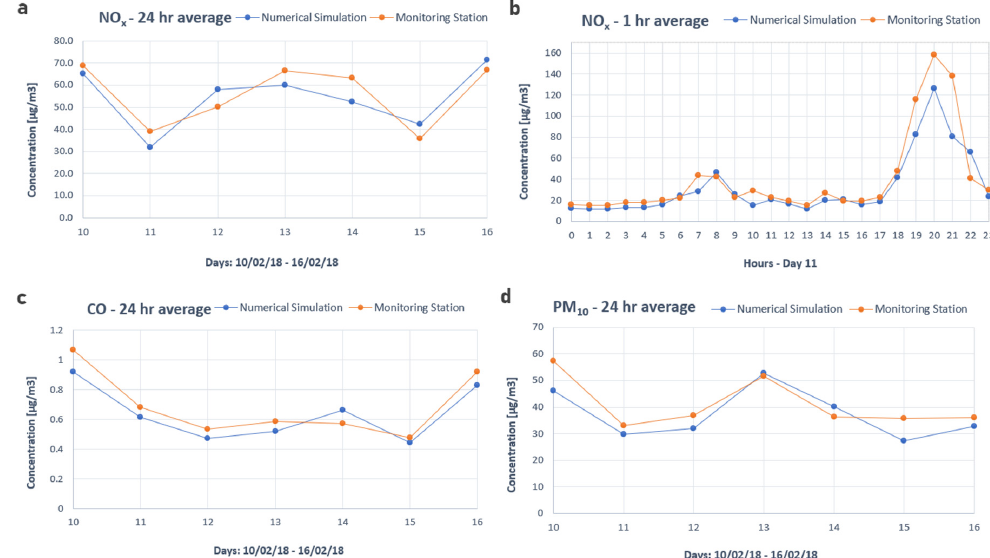
Figure 6. Timeseries of measurements (orange) [73] and present calculations (blue) for ( a ) 24 h and ( b ) 1 h average of NO x concentration and 24 h average of ( c ) CO and ( d ) PM 10 at Nea Smyrni Station (Figure 4).